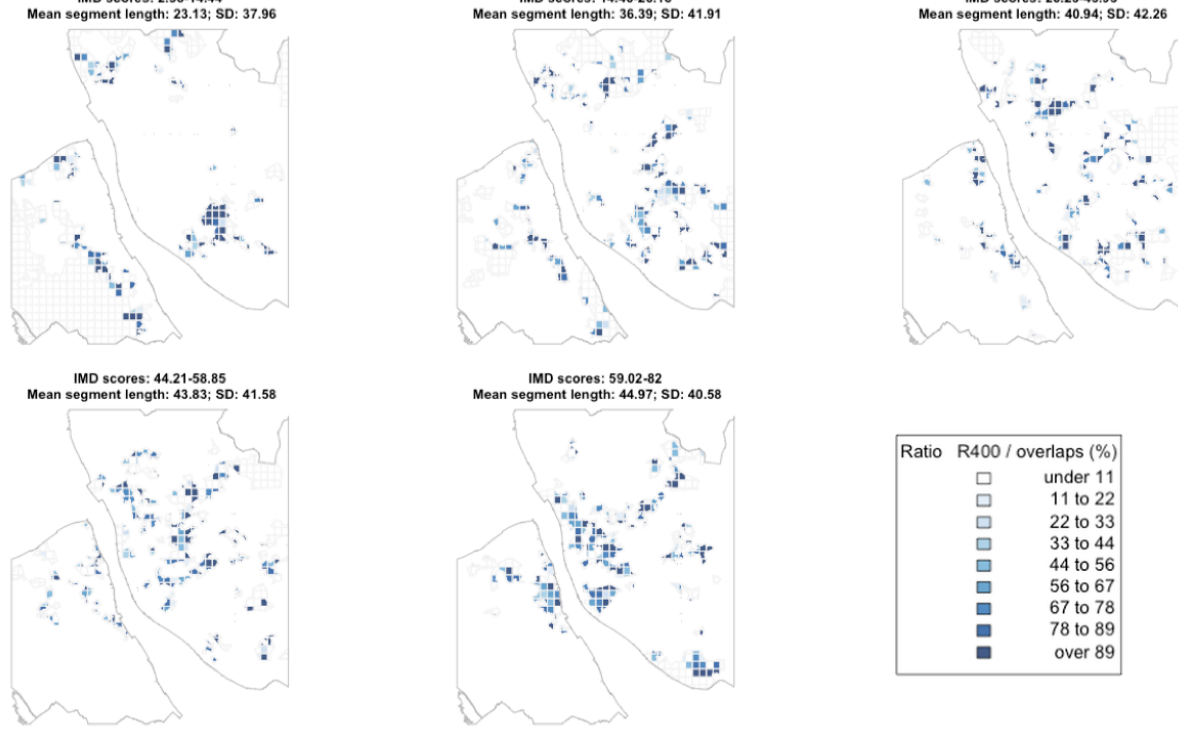
Figure 14. A choropleth array representing total lengths of network segments with ‘overlapping’ movements in each square subdivision as a ratio (%) of all network segments in that area. The sampling grid (raster) has been clipped based on IMD score quintile ranges. The plots run high IMD score top left to low IMD score bottom